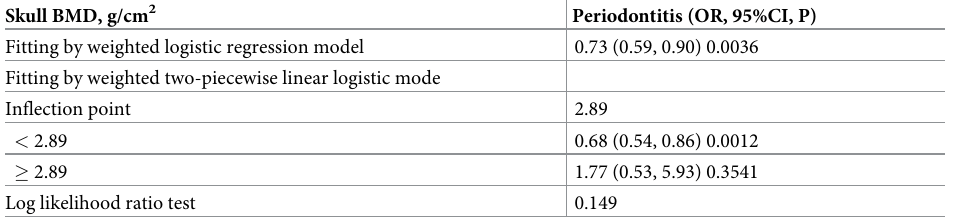
Table 3. Threshold effect analysis of the skull bone mineral density and periodontitis using piece-wise logistic